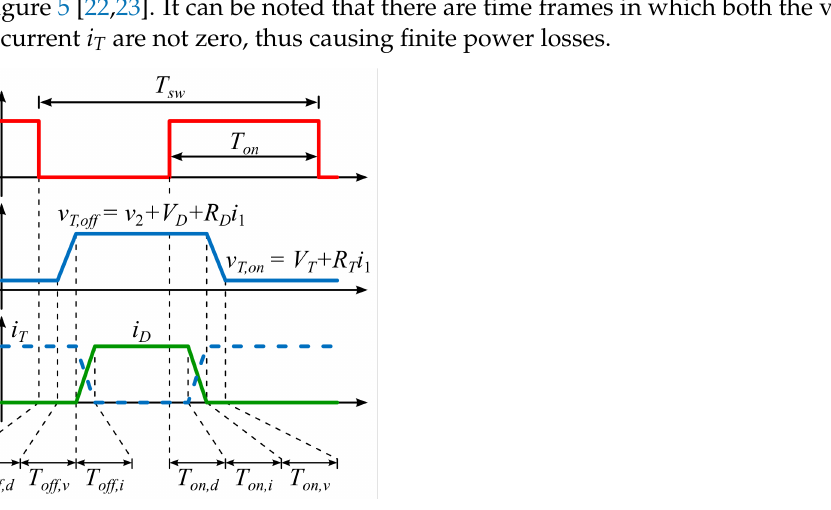
Figure 5. Electronic switch voltage and diode current during turn-on and turn-off transients.